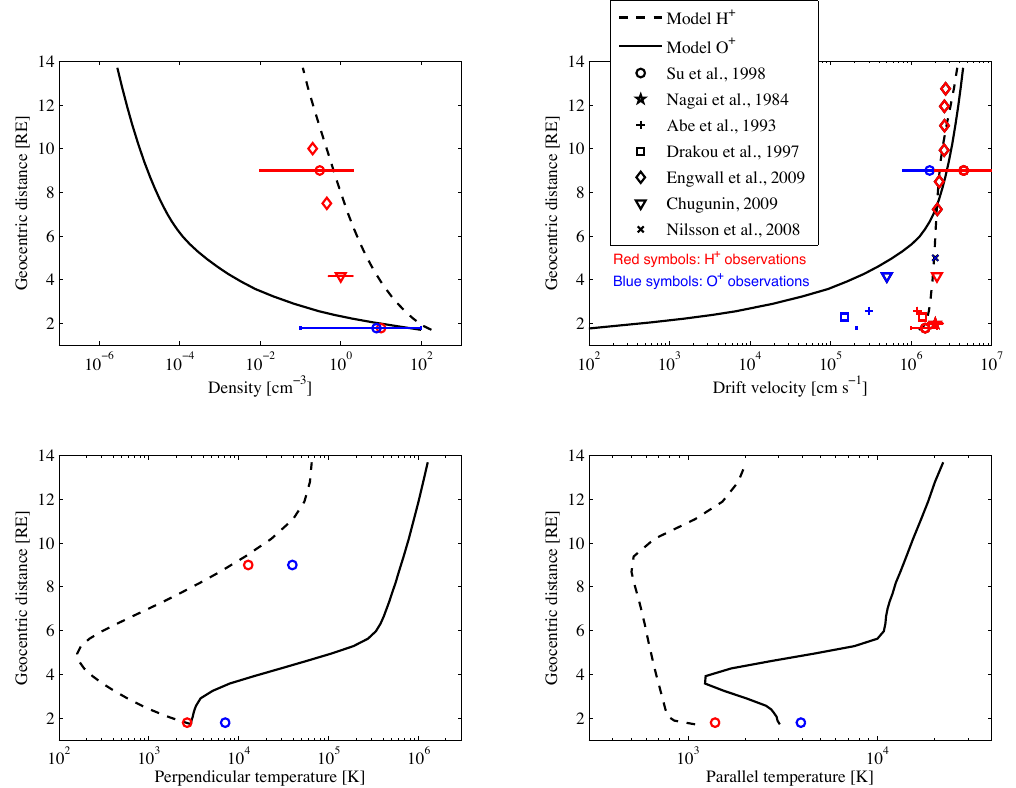
Fig. 6. Altitude profiles of the lower order moment for O + ions (solid line) and H + ions (dashed line) when λ ⊥ = 8km. The moments h i h i considered here are: density n cm − 3 (top left), drift velocity u cm − 3 (top right), perpendicular temperature T ⊥ [ k ] (bottom left), and parallel temperature T k [ k ] (bottom right). Different corresponding observations are marked on the